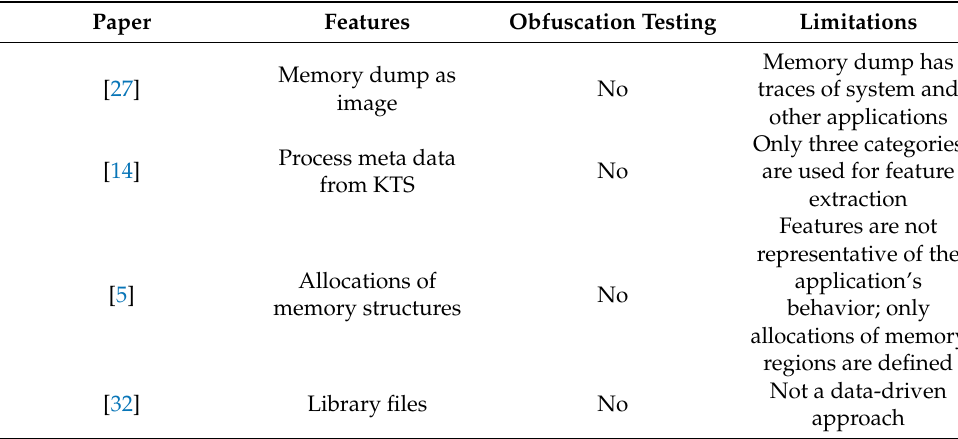
Table 1. Related work on malware detection using kernel task structure